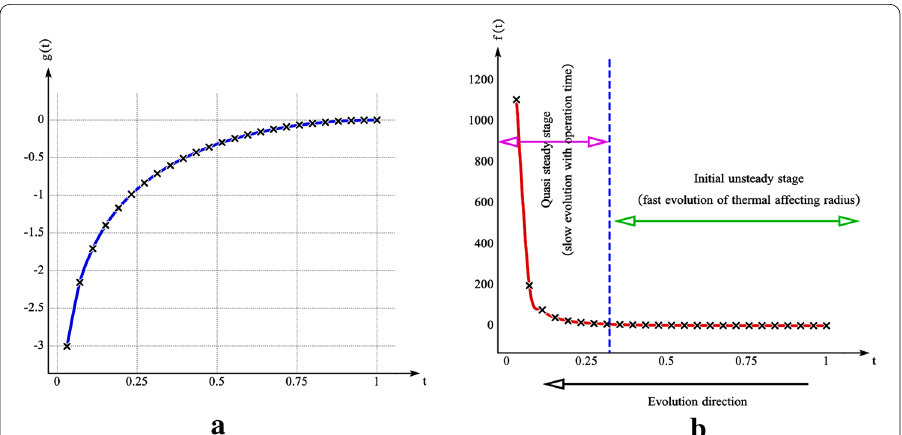
Fig. 4 a Temperature distribution function g ( t ) in the thermal impacted circle. b Evolution of the radius of thermal impacted circle depicted by function f ( t